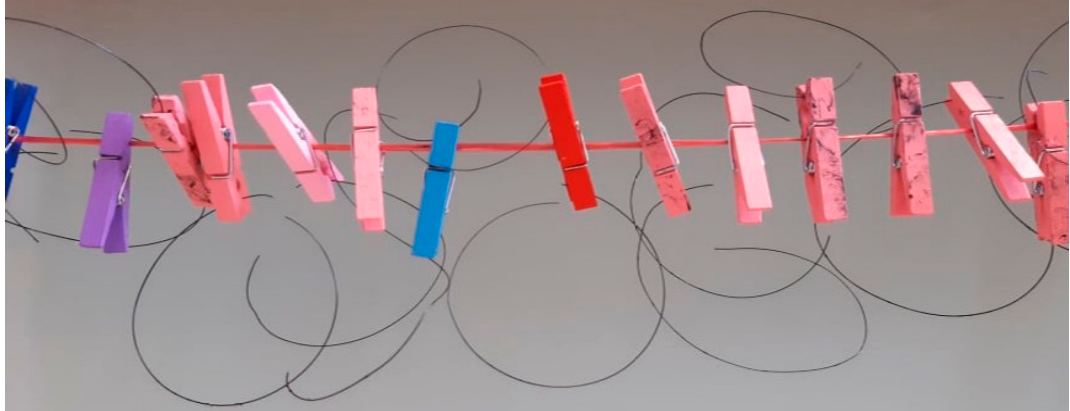
Figure 4. Line drying system for drying PEDOT:PSS coated conductive yarns.